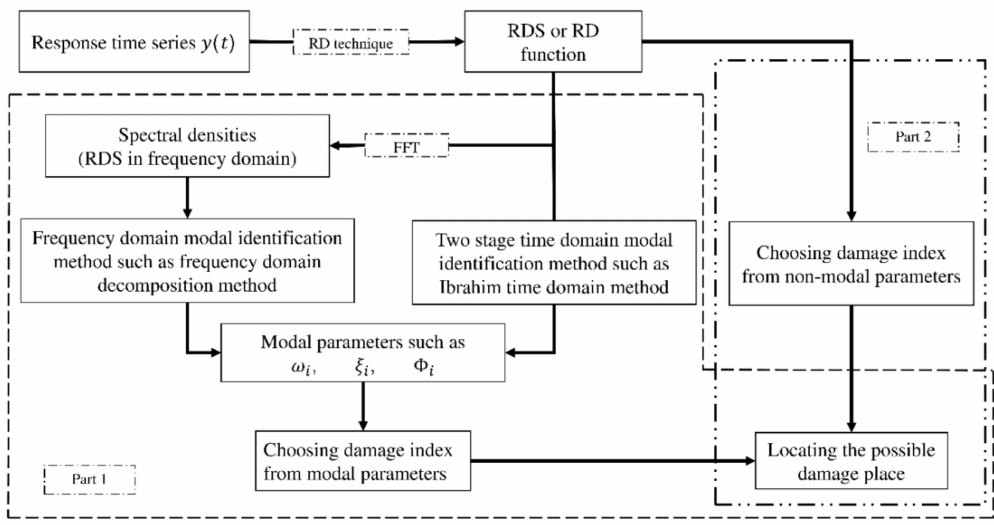
Figure 1. General scheme of damage detection using RD